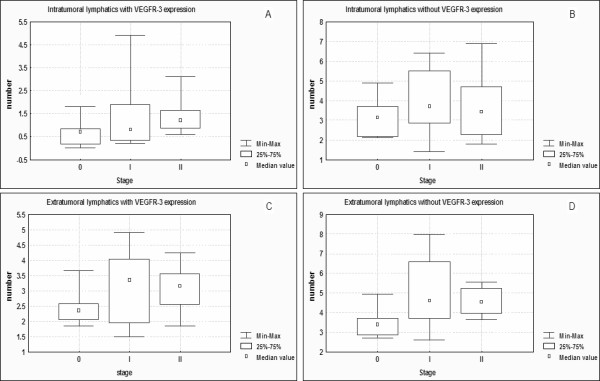
Number of lymphatics with and without VEGFR-3 expression in intratumoral (A, B) and extratumoral (C, D) fields in stage 0, stage I and stage II malignant tumours.